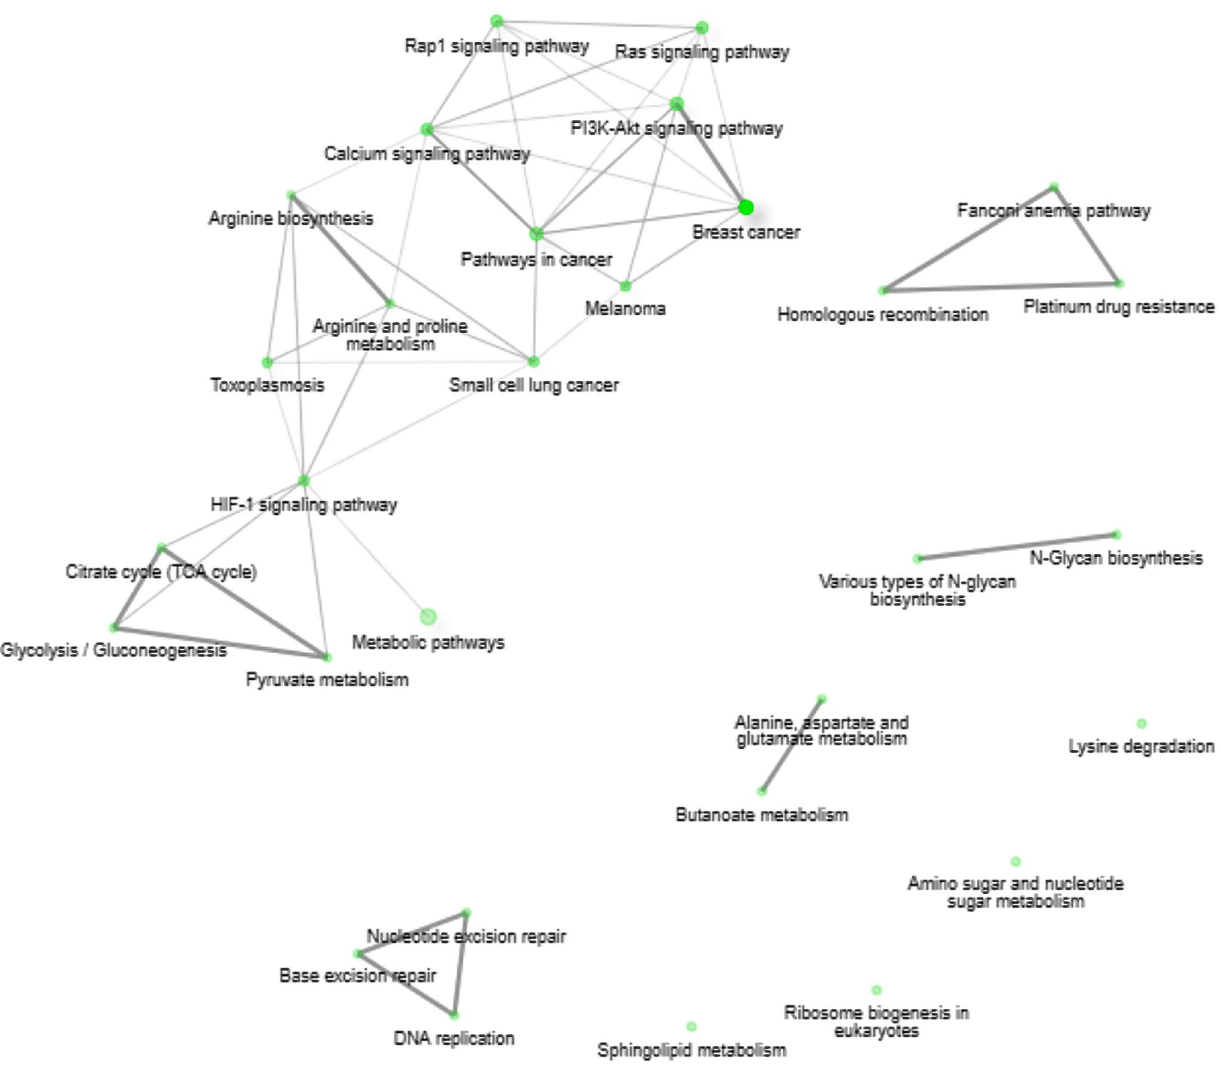
Fig. 9 Pathway analysis. The DEG from the TARGET (BM vs PB) samples were analyzed through PATHVIEW and an enrichment analyisis was done using the KEGG database. The resulting pathway network shows the Ras and PI3k-Akt pathways, related to genes IL7R and